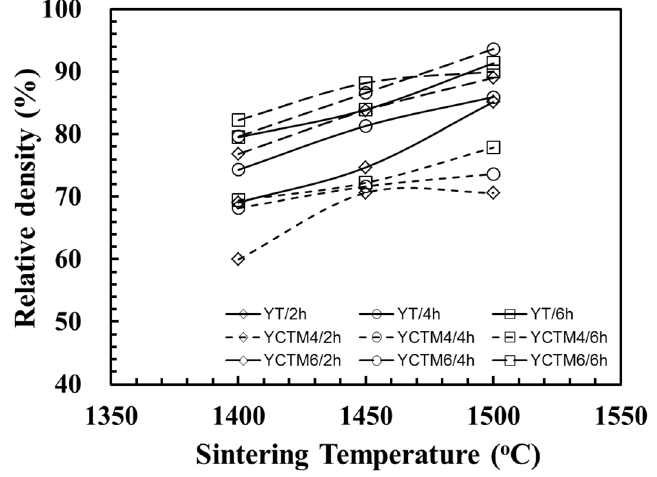
Figure 2. Relative density of YT, YCTM4, and YCTM6 ceramics sintered at various temperatures and soak